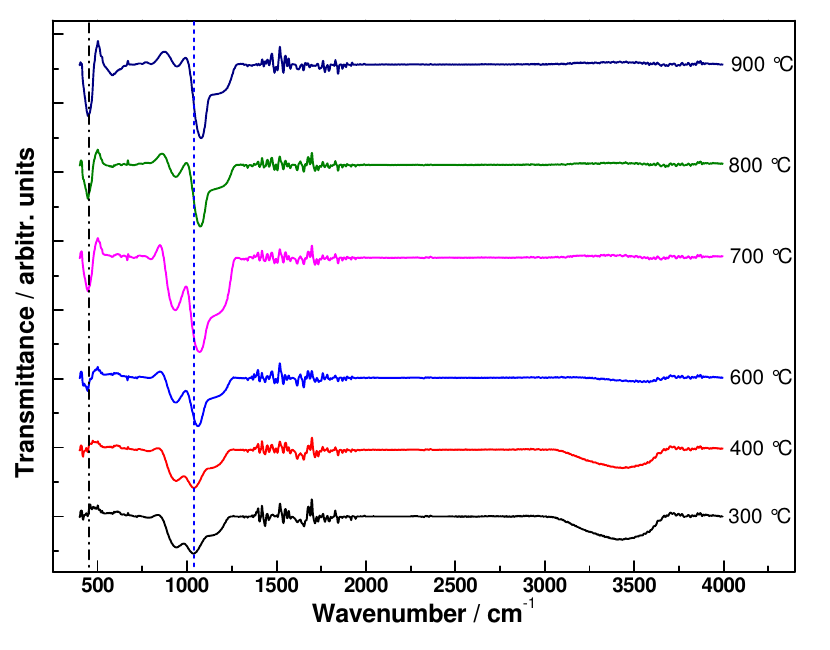
Figure 2. Fourier Transform Infrared spectra of coatings annealed at different temperatures.